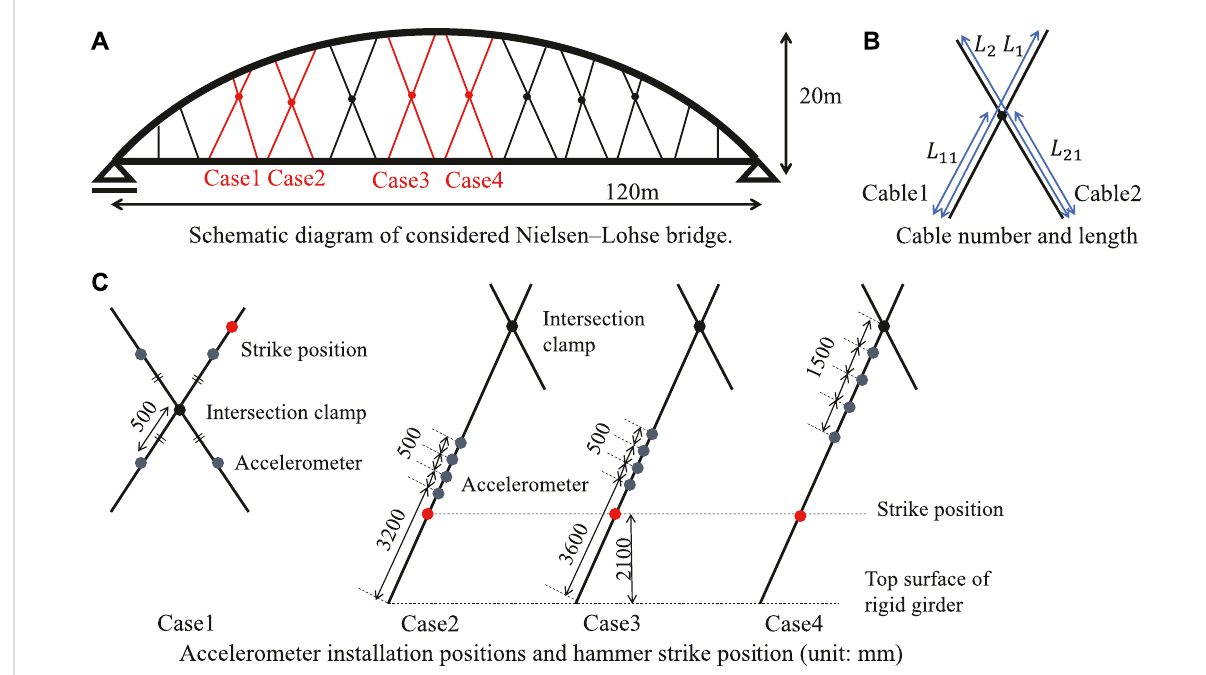
FIGURE 8 Outline of fi eld experiment. (A) Schematic diagram of considered Nielsen – Lohse bridge. (B) Cable number and length. (C) Accelerometer installation positions and hammer strike position (unit: mm).